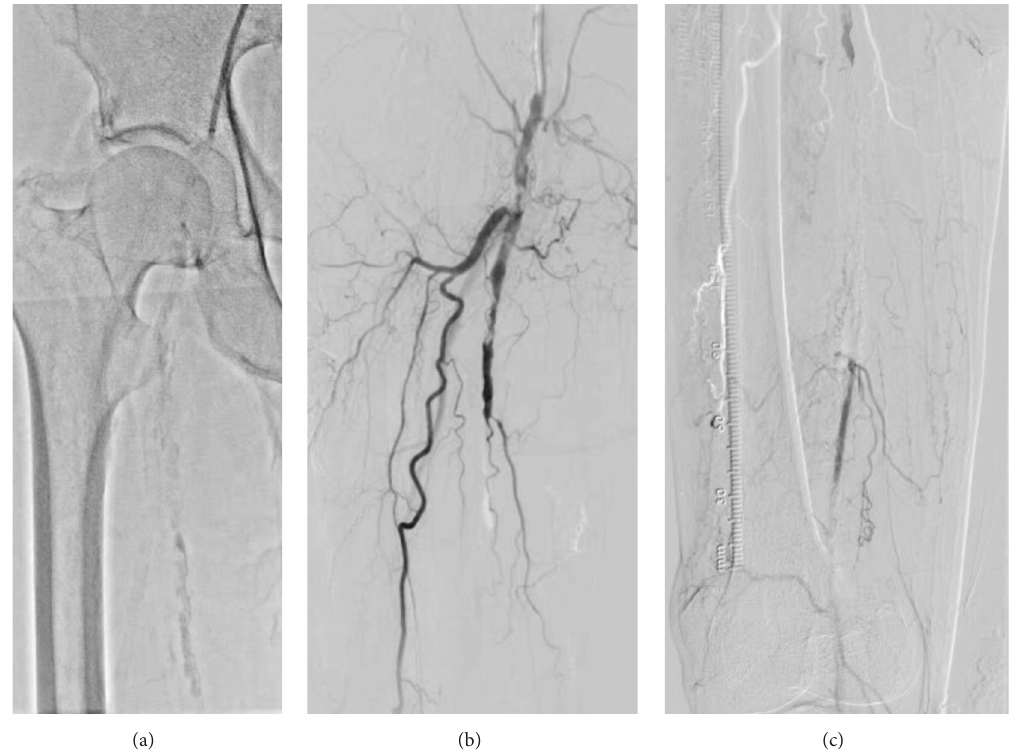
Figure 1: The first angiogram. (a) Digital angiography shows severecalcification of the right superficial femoral artery. (b) Digital subtraction angiography of the proximal part indicates the chronic total occlusion of the middle superficial femoral artery. (c) Digital subtraction angiography of the distal portion presents the puncturable distal superficial femoral